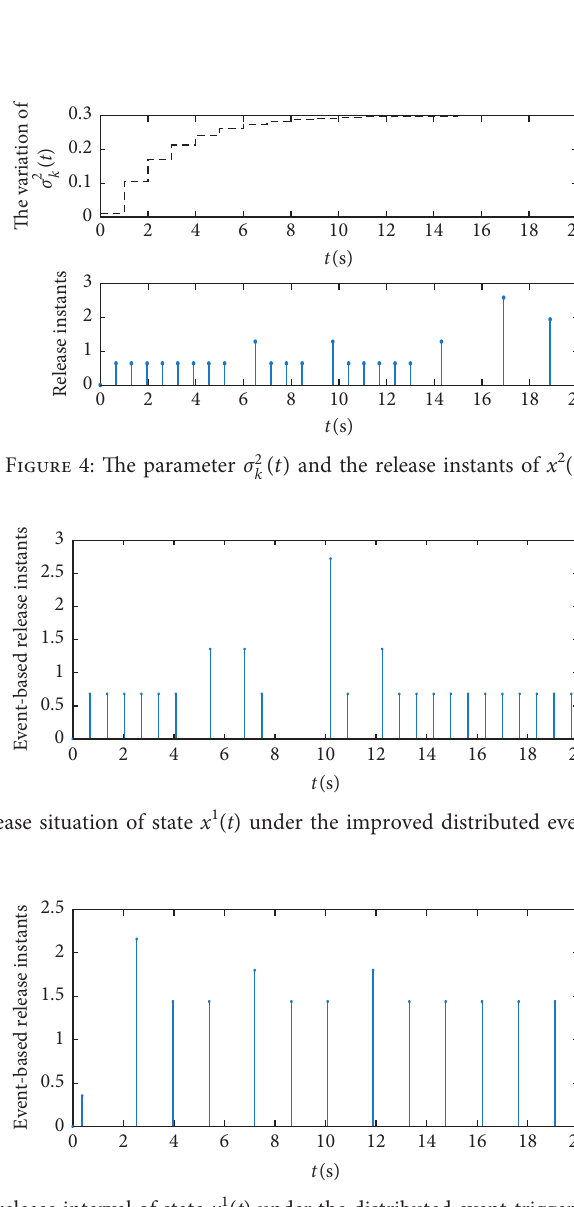
Figure 6: The release instants and release interval of state x 1 ( t ) under the distributed event-triggered scheme with constant parameter σ .